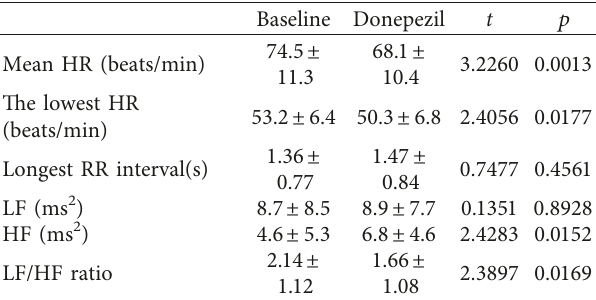
Table 2: Holter electrocardiogram and HRV at baseline and 4 weeks after donepezil intervention.